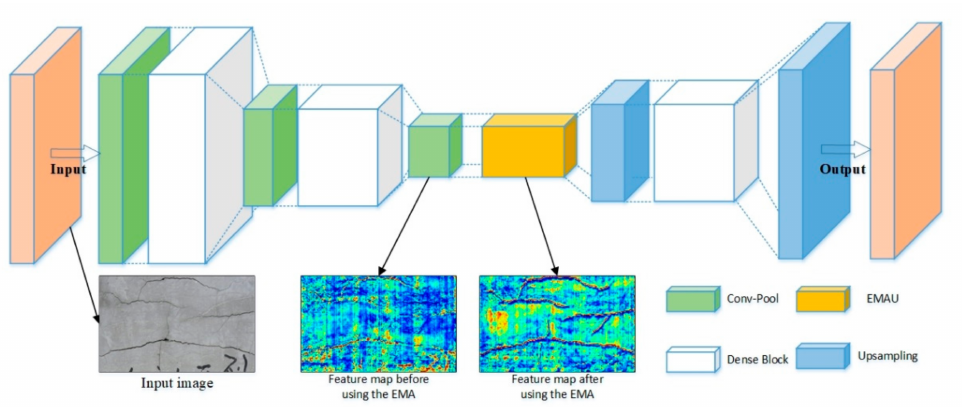
Figure 4. Overall architecture of the proposed